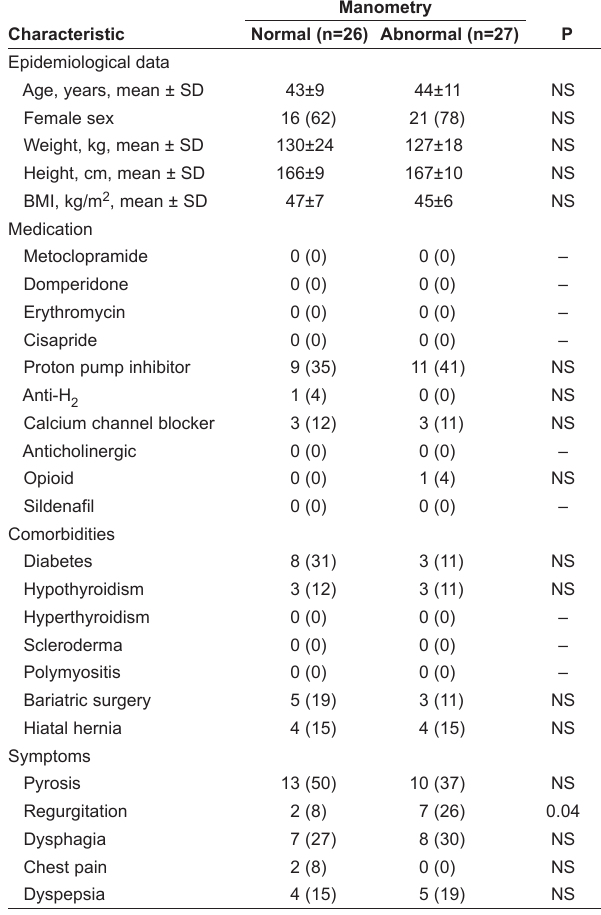
TAble 1 Comparison of clinical characteristics between patients with normal and abnormal manometry